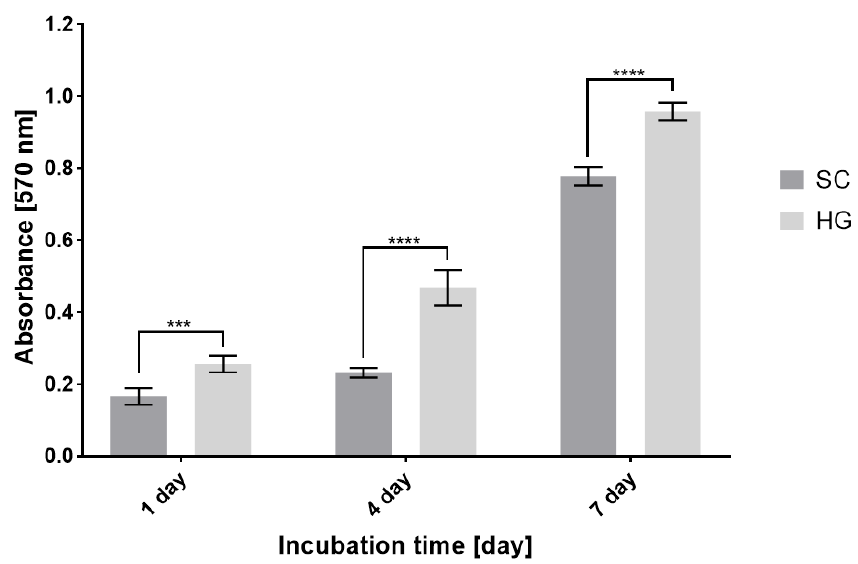
Figure 6. Cell metabolic activity described by the MTT Assay—comparison of surface bioprinting and conventional cell seeding (mean value ± standard deviation, n = 4). Statistically significant difference in the significance level: *** p < 0.0006; **** p < 0.0001. SC—scaffolds with conventionally seeded cells, HG—scaffolds with a printed hydrogel bioink.